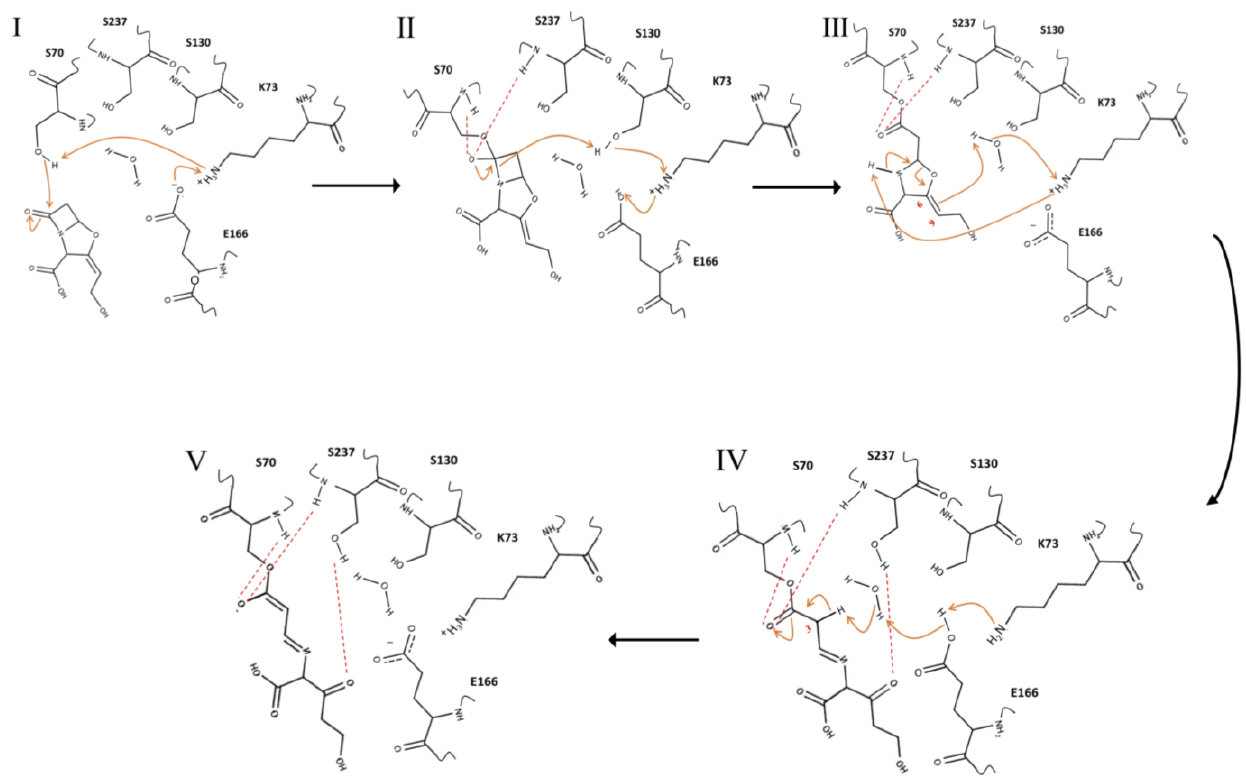
Figure 7. The proposed mechanism for clavulanic acid inhibition of CTX-M-15. Orange colored lines indicate electron transfer and red dashed lines indicate hydrogen bond interactions.